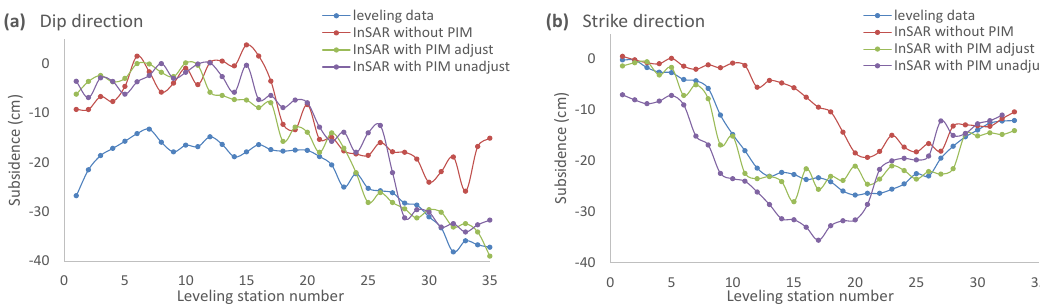
Figure 7. Results comparison of different